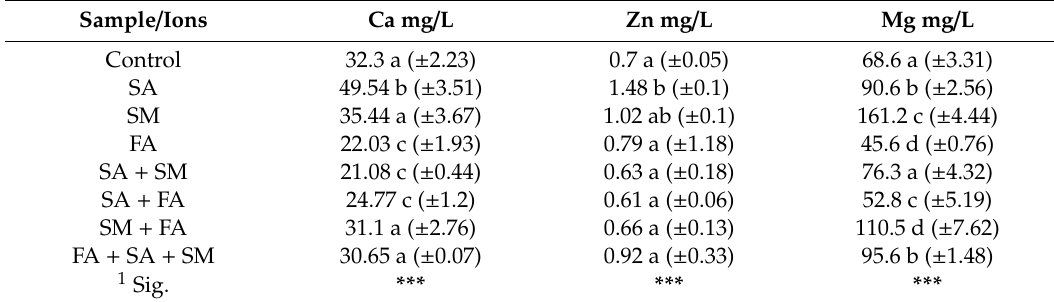
Table 3. The content of selected ions in ciders fermented by cider yeast (C), with the following additions: SA—ammonium sulfate, SM—magnesium sulfate, FA—ammonium